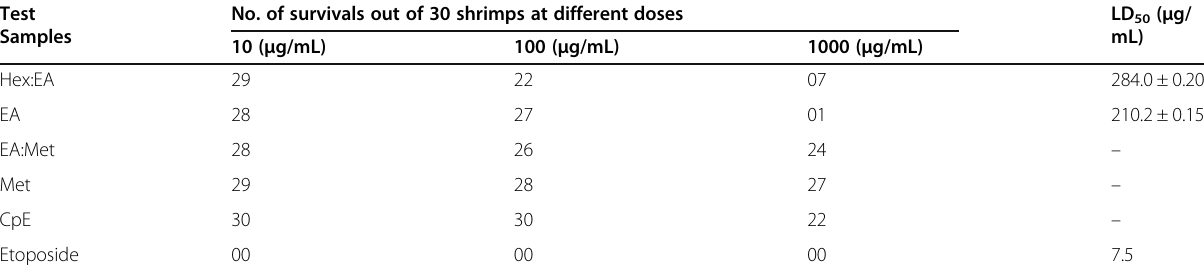
Table 2 Cytotoxic effect of Spondias mombin stem bark and Etoposide at various concentrations against shrimps of Artemia salina Test Samples